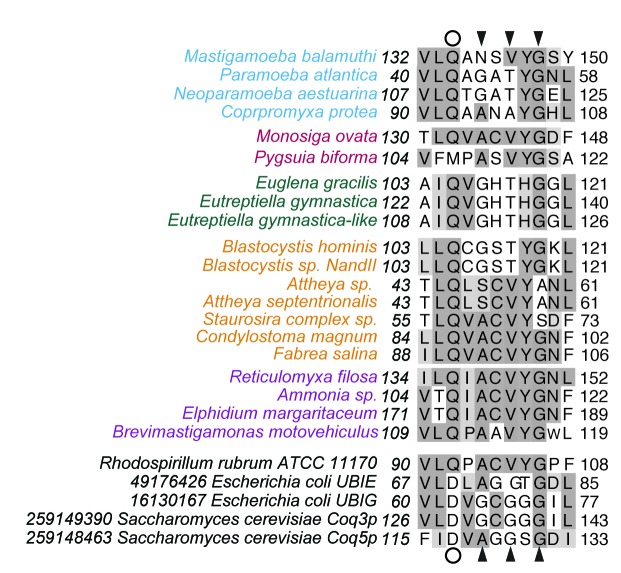
RquA homologues lack critical S-adenosyl methionine (SAM) binding site.Conserved residues known to interact with the carbonyl group of SAM are shown with black triangles. A substitution from aspartate to glutamine was obversed in all bacterial (represented here by Rhodospirillum rubrum) and eukaryotic RquA demonstrated with a open circle. Taxa are coloured with super-Group Affiliation as in Figure 2. Motif features: [VILFG]-[LIVCS]-[DENLV]-[VALMIT]-[GLYCFA]-[CSTAYFPAG]-[GA]-[PTSGNKRMV]-[GD]).